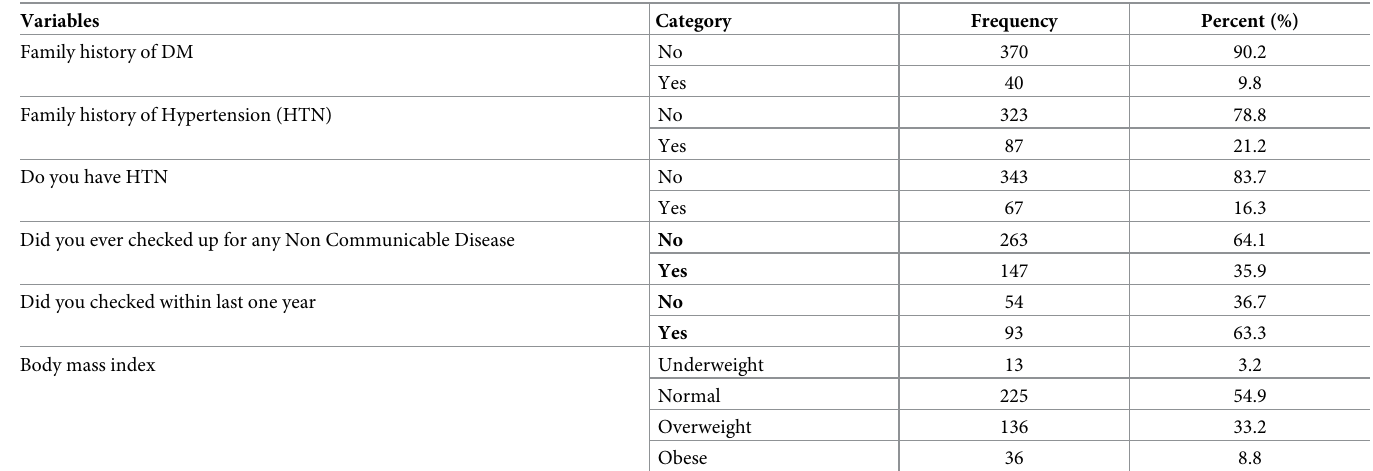
Table 4. Clinical characteristics of the governmental employees at East Guji Zone, Southern Ethiopia,